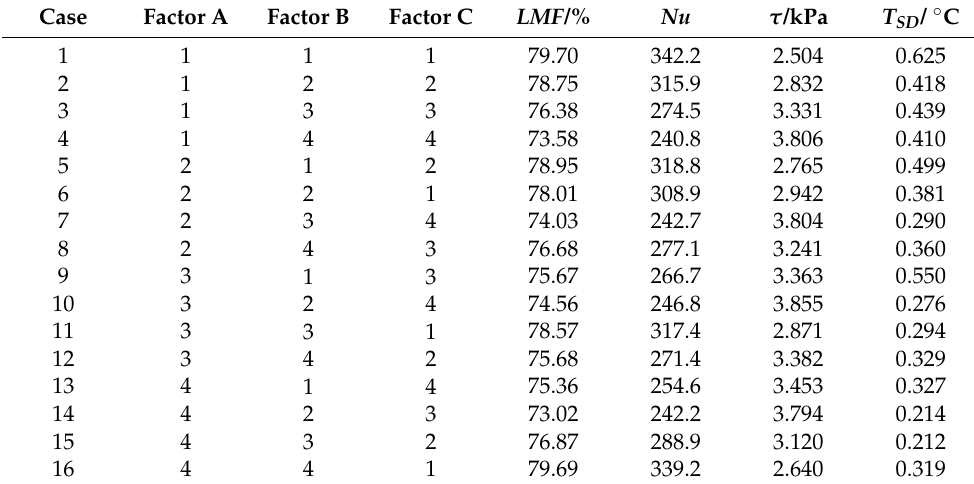
Table 6. Orthogonal experimental schemes and results at 75 r/min.